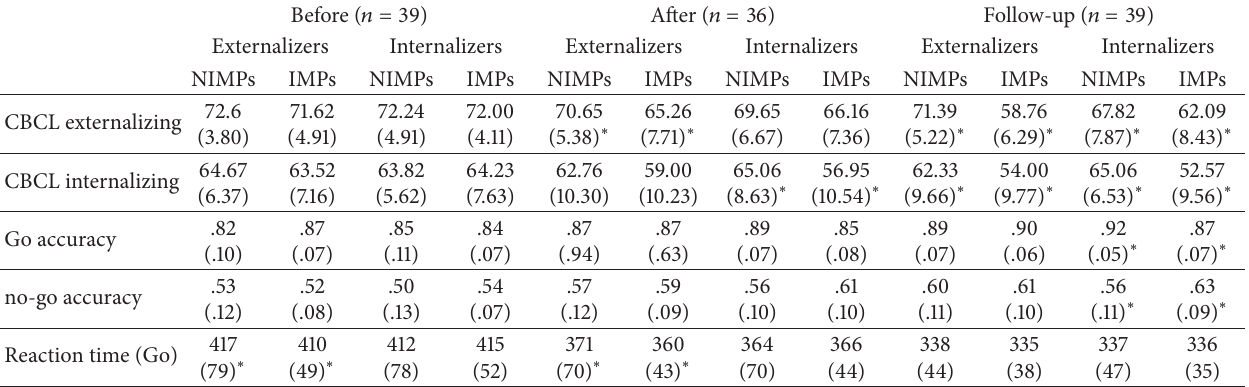
Table 2: CBCL and behavioral performance data (mean and standard deviations) during the Go/No-go task before treatment, after treatment, and for follow-up, broken down for when groups were divided on changes in externalizing or internalizing symptoms. NIMPs: nonimprovers; IMPs: improvers. Statistical differences between long-term improvers (IMPs) and nonimprovers (NIMPs) were tested at each time point using 𝑡